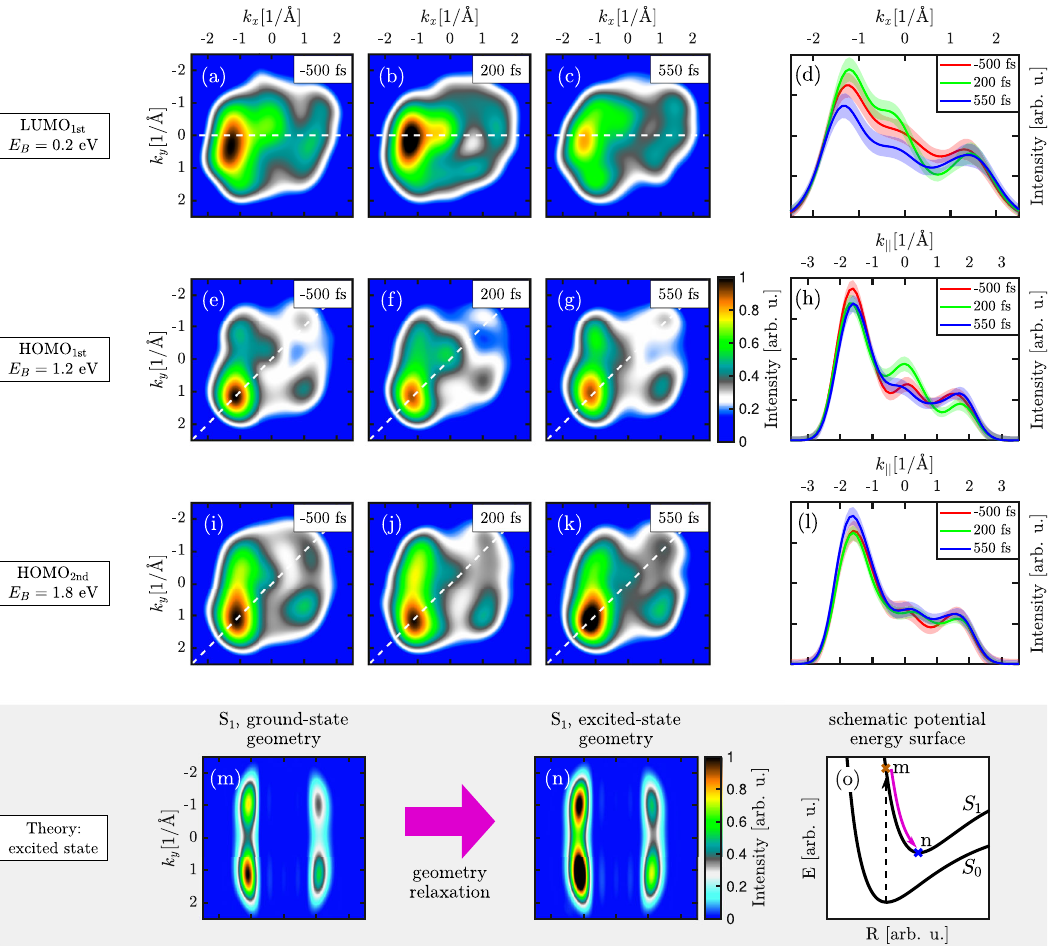
Fig. 4 Time evolution of experimental photoelectron momentum maps (PMMs) and comparison to theory. PMMs of pentacene of the ( a – c ) LUMO 1st , ( e – g ) HOMO 1st and ( i – k ) HOMO 2nd at E B = 0.2 eV, E B = 1.2 eV and E B = 1.8 eV binding energy, respectively. The PMMs are integrated in intervals of 350 fs and smoothed in momentum space with a Gaussian fi lter. Momentum distribution curves for ( d ) LUMO 1st , ( h ) HOMO 1st and ( l ) HOMO 2nd (bottom) in the direction as indicated by the dashed lines in the corresponding PMMs. The shaded bands re fl ect 1 σ error-bars. Calculated PMMs for a pentacene molecule excited to the fi rst singlet state ( m ) in the ground-state geometry and ( n ) excited-state geometry. ( o ) Schematic representation of the proposed molecular dynamics in the second layer after excitation: the shape of a molecule changes after the electronic